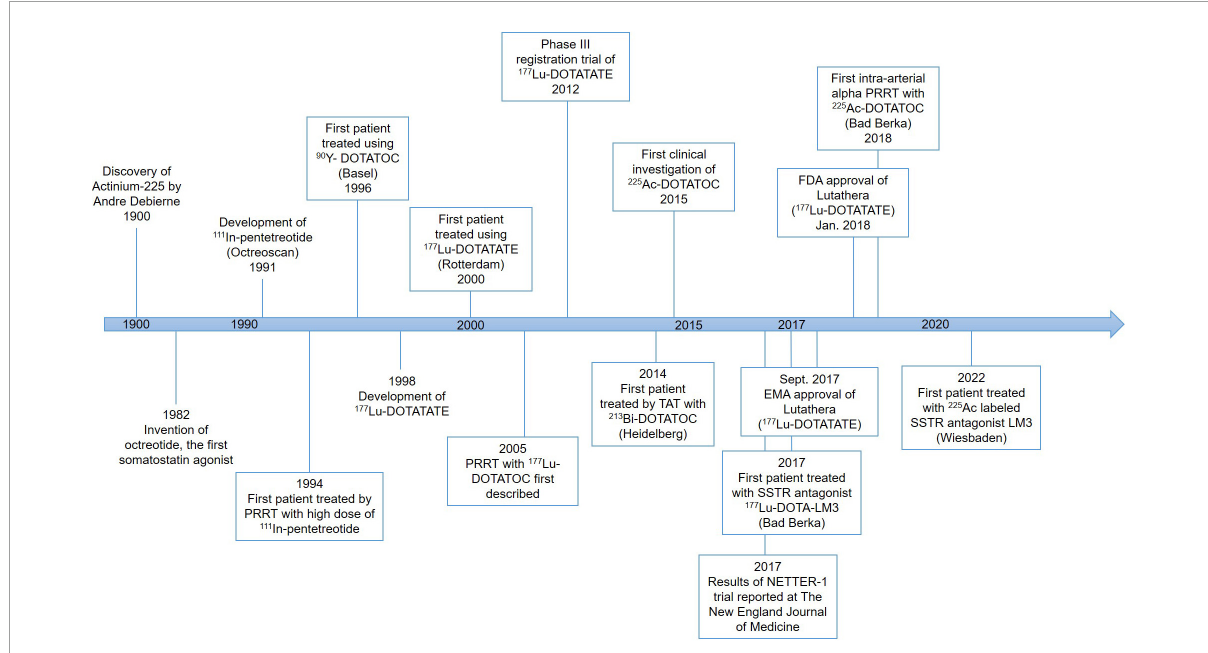
FIGURE1 History of somatostatin-based peptide receptor radionuclide therapy (PRRT).